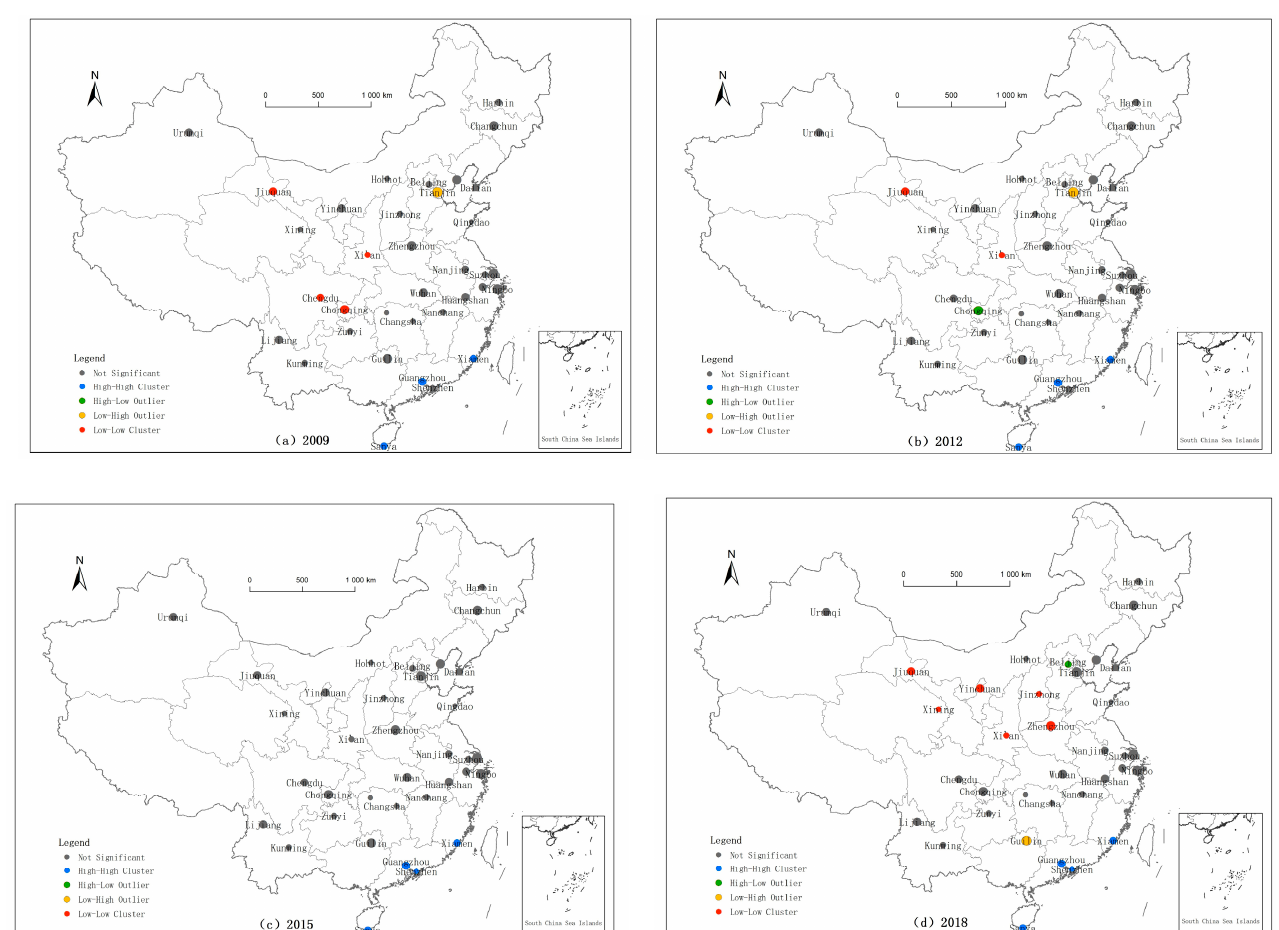
Figure 8. Local autocorrelation LISA clustering of the tourism urbanization indexes of major tourist cities in